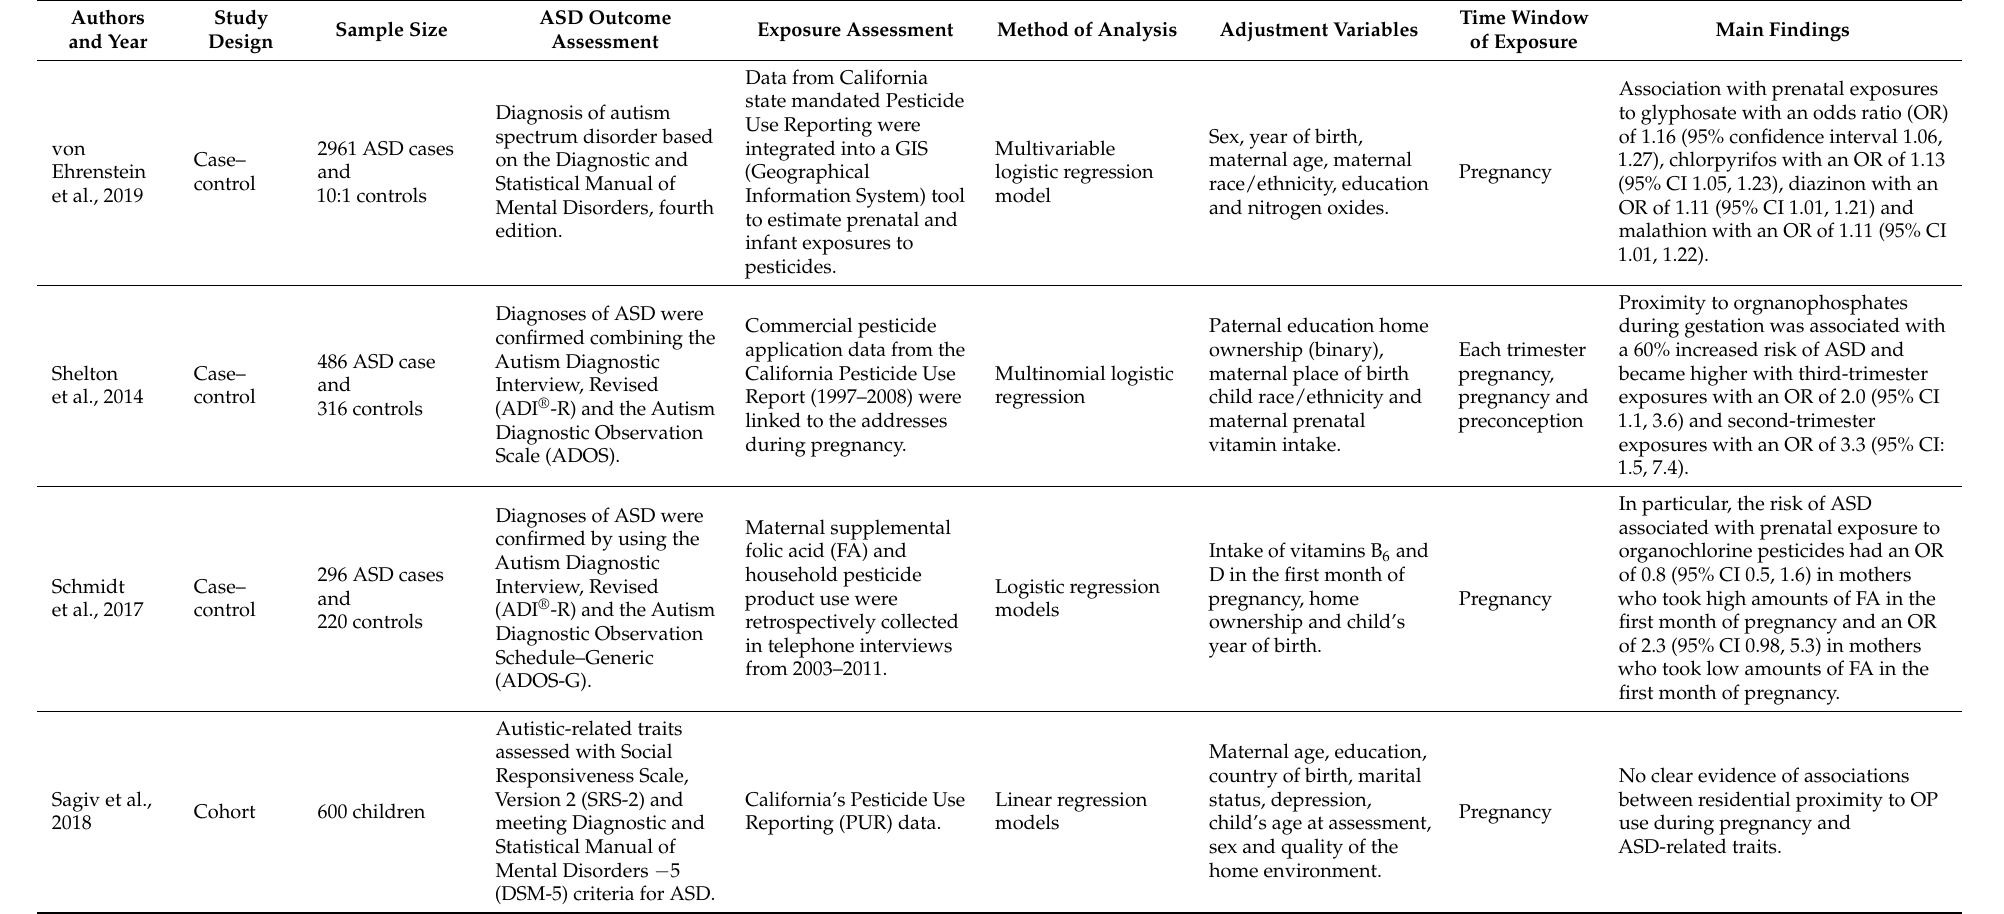
Table 1. Associations between organophosphates (OPs) and autism spectrum disorder